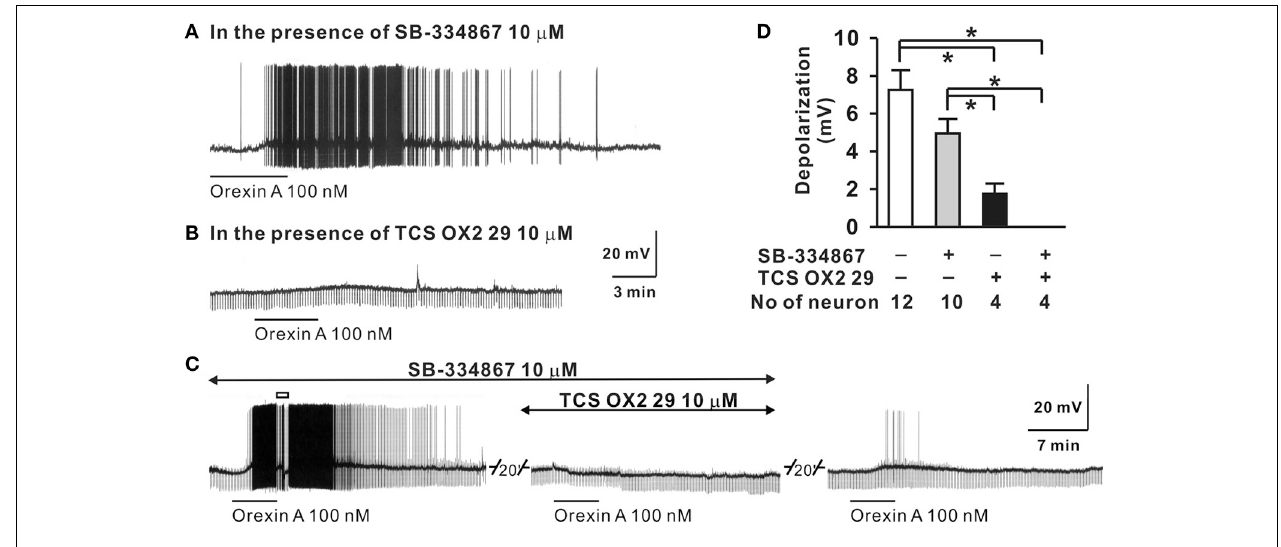
FIGURE 2 | Orexin A excites RVLM neurons in vitro . The OX-A induced depolarization of RVLM neurons (D) was: (1) not significantly affected by OX 1 R antagonist SB-334867 (A,D) , (2) significantly reduced by an OX 2 R antagonist, TCS OX2 29 (B,D) , and (3) abolished by simultaneous application